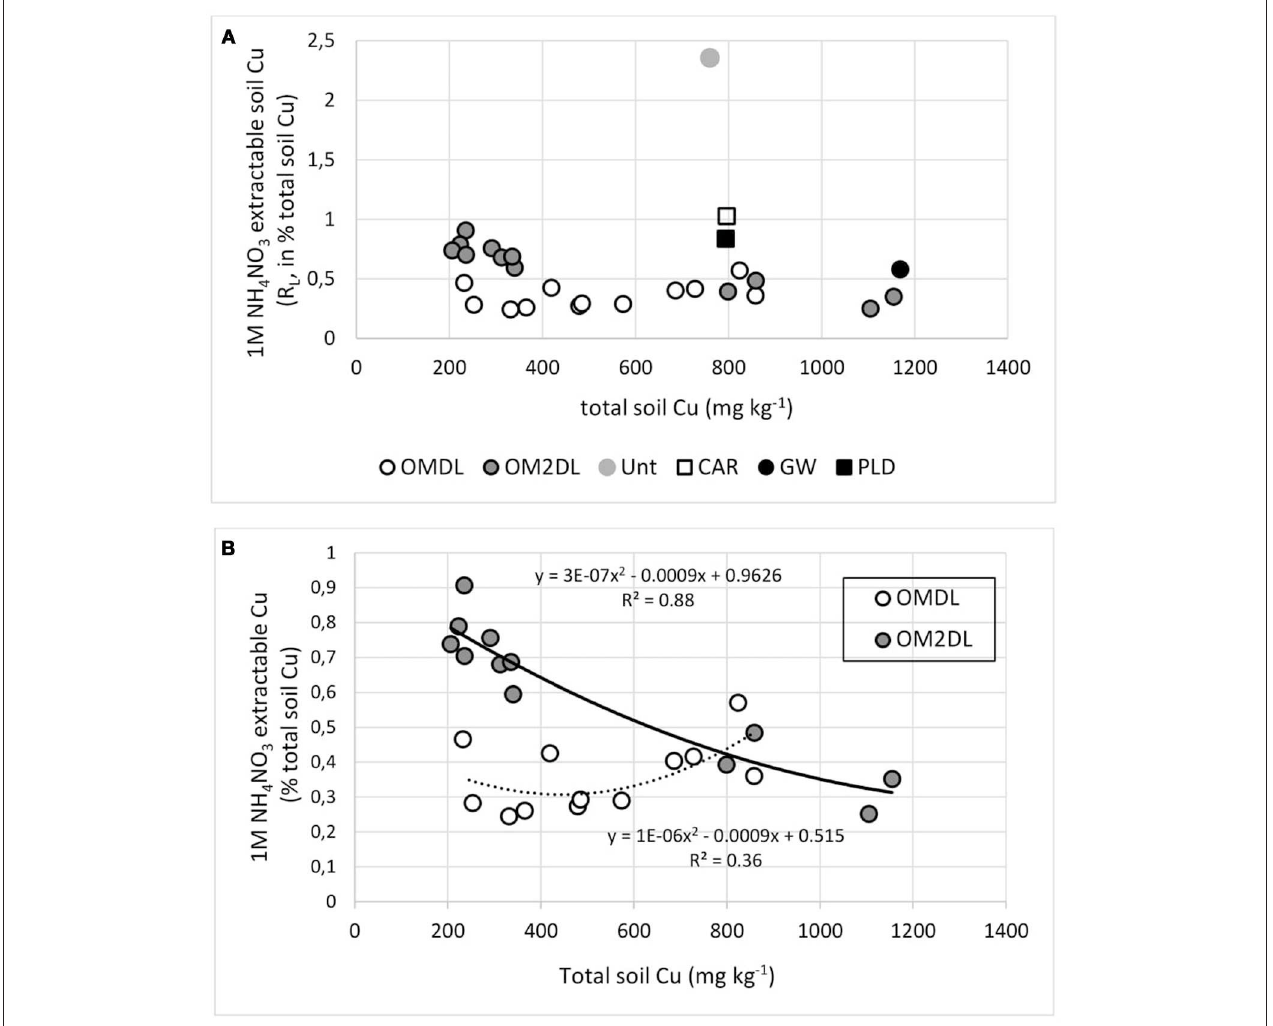
these decreases were not significant as well as in the B2 plots ( Figure S5 ). The potential cumulative effects of annual shoot Cu removal and Cu leaching for decreasing total topsoil Cu were not statistically evidenced in year 10. Total topsoil Cu still exceeded the pedogeochemical Cu background and screening values, notably for French sandy soil ( Table 3 ; Saby et al., 2009). Spatial variability of total topsoil Cu, such as the “hot spot” at the edge of the GW plot, was mainly attributed to variability in cumulative wood washings resulting from long-term storage of preserved wood. Based on its composition ( Table 2 ; Oustriere et al., 2016) and addition rate, Cu inputs by the green waste compost was negligible (4.3 mg Cu kg − 1 soil, 1.9 g Cu plot − 1 ) regarding total topsoil Cu (0.4%). The ratio of total topsoil Cu vs. total subsoil Cu was in the 0.99–1.09 range for all plots, except for the B3:OM2DL plots where its value decreased to 0.82. This